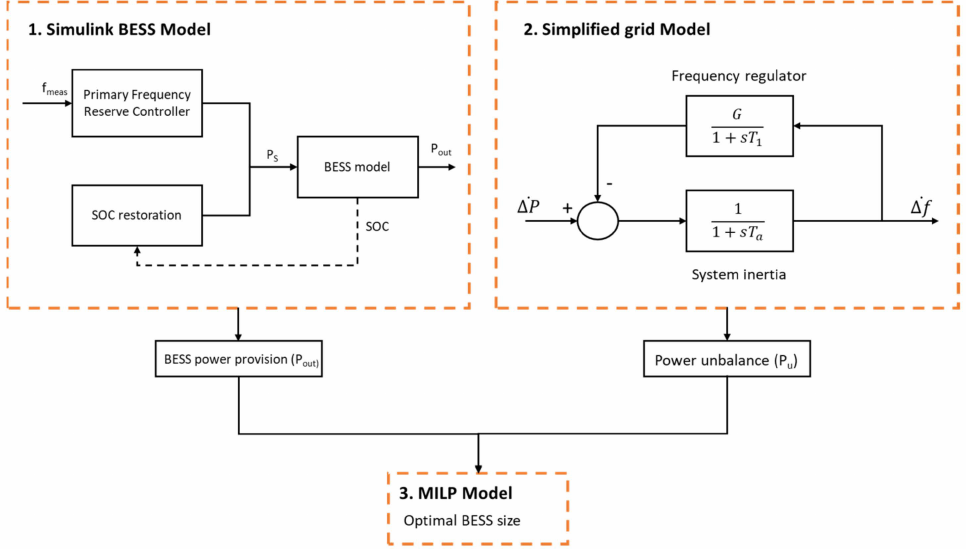
Figure 6. A schematic representation of the proposed